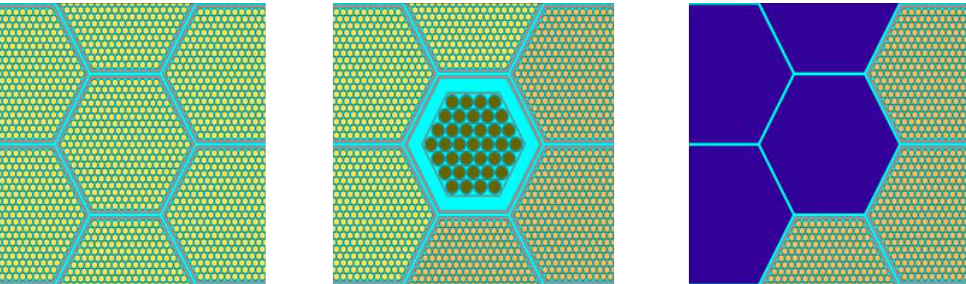
Figure 2: Serpent 2D Inputs (left - inner core infinite lattice, middle - primary CR, right - radial